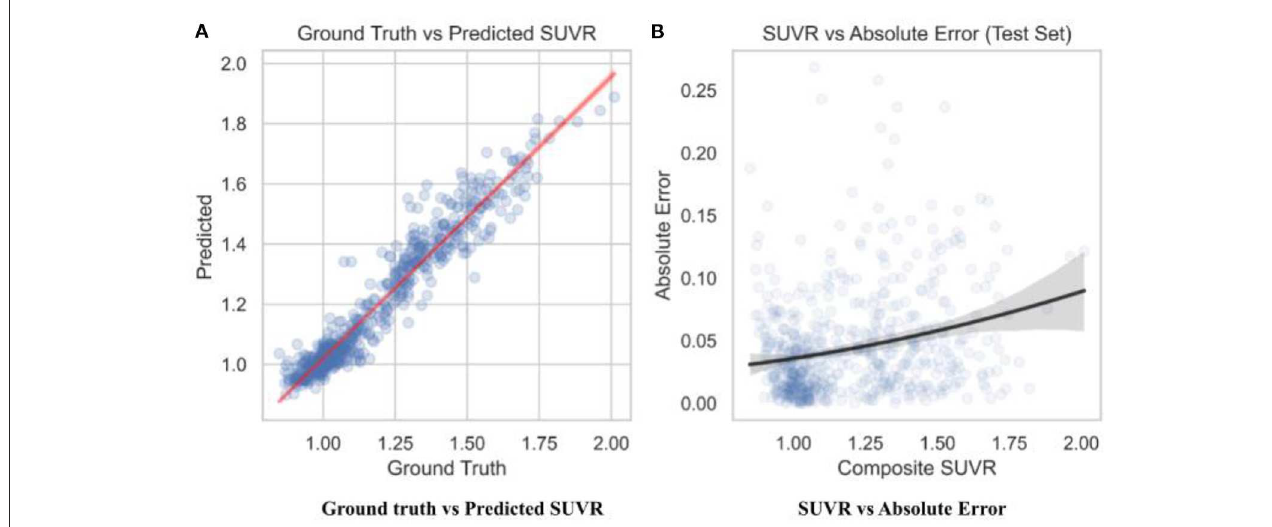
FIGURE6 Predicted SUVR vs. various variables. All data shown was taken from the test set only ( n = 596). (A) RegNet + GBDT ground truth vs. predicted SUVR. (B) RegNet + GBDT SUVR vs. absolute